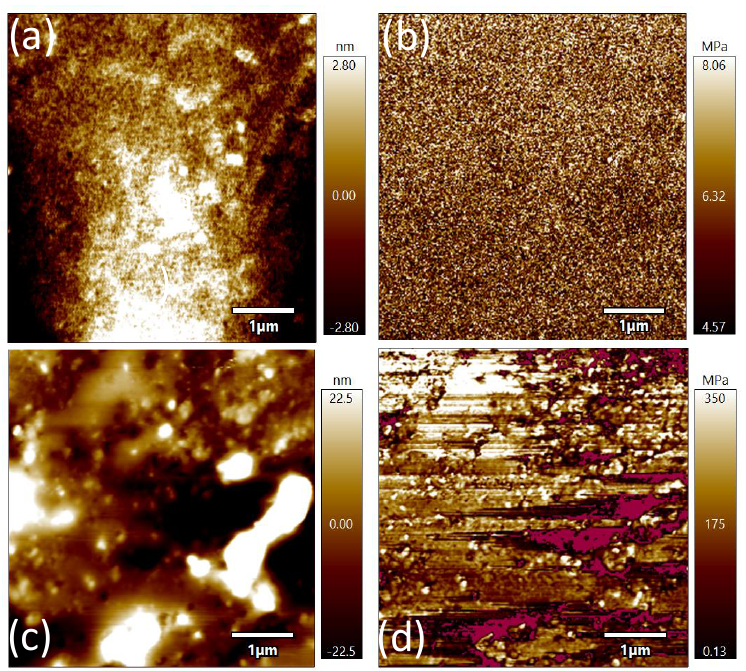
Figure 3. Surface structure of the dielectric substrate ( a ) and the dielectric substrate ( c ) under atomic force microscope. ( b ) Surface structure of the dielectric substrate and Young’s modulus ( d ) under radiation patch and Young’s modulus.